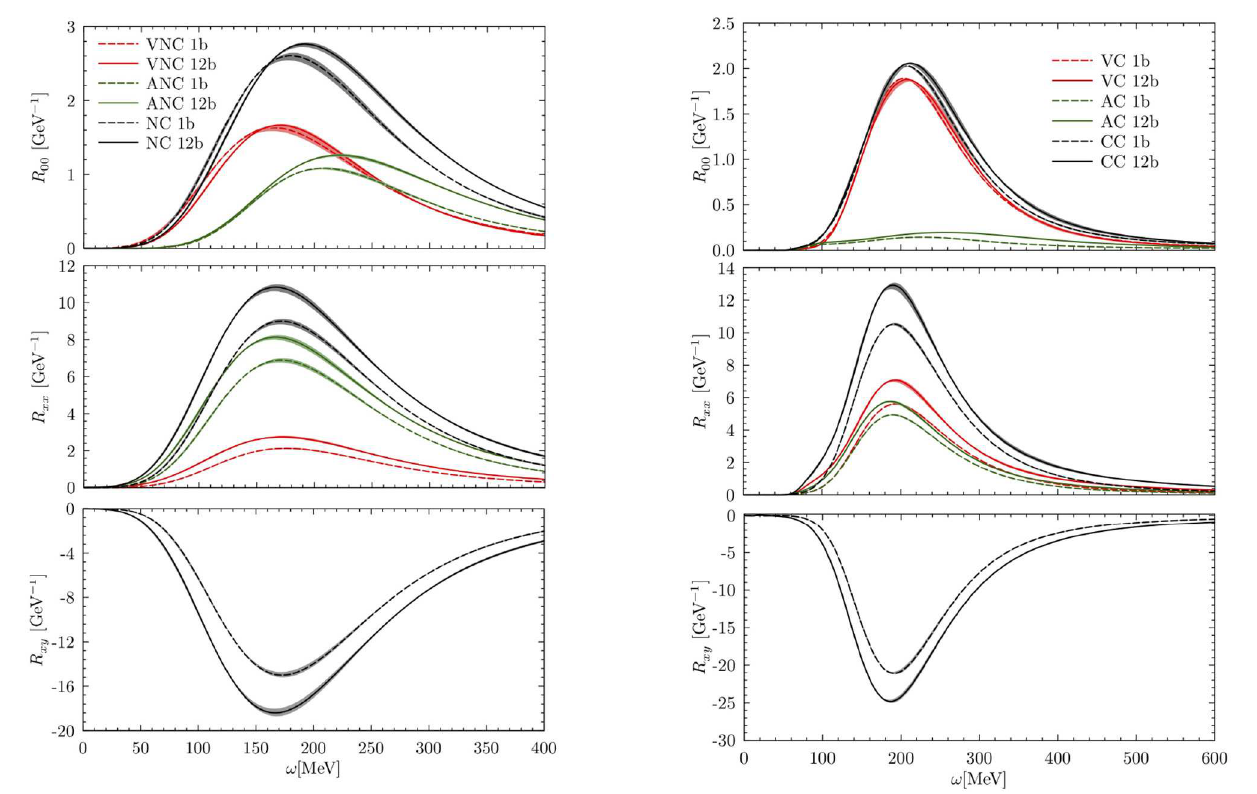
FIGURE 4 | (Left) Adapted from Lovato et al. [26] under the Creative Commons CCBY license. Neutral-current response functions in 12 C at momentum transfer | q | = 570 MeV obtained with one-body only (dashed lines) and one- and two-body (solid lines) currents. The vector and axial contribution corresponds to the red and green curves, the black curves display the full result in which the axial-vector interference is accounted for. The upper, middle, and lower panel corresponds to the charge, transverse and xy component of the response function. (Right) Charge-current response functions in 4 He at momentum transfer | q | = 600 MeV. The different lines are the same as for the left